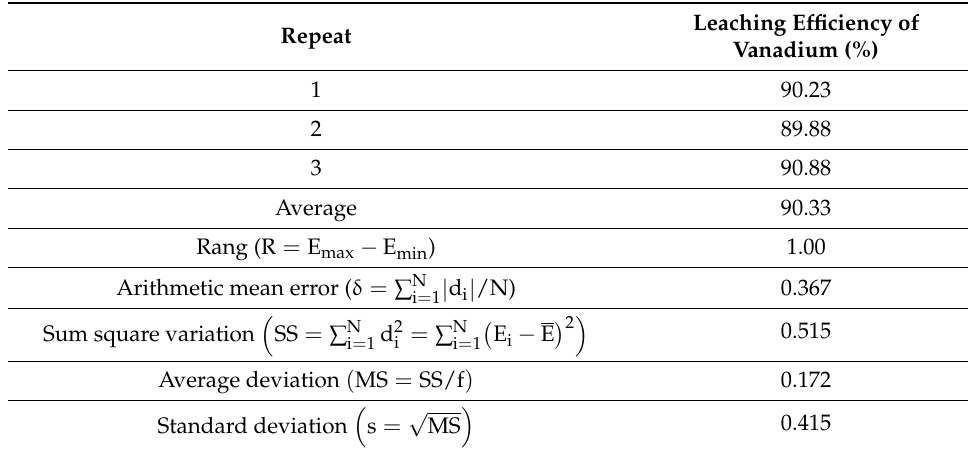
Table 2. Results of the repeated tests of vanadium extraction.